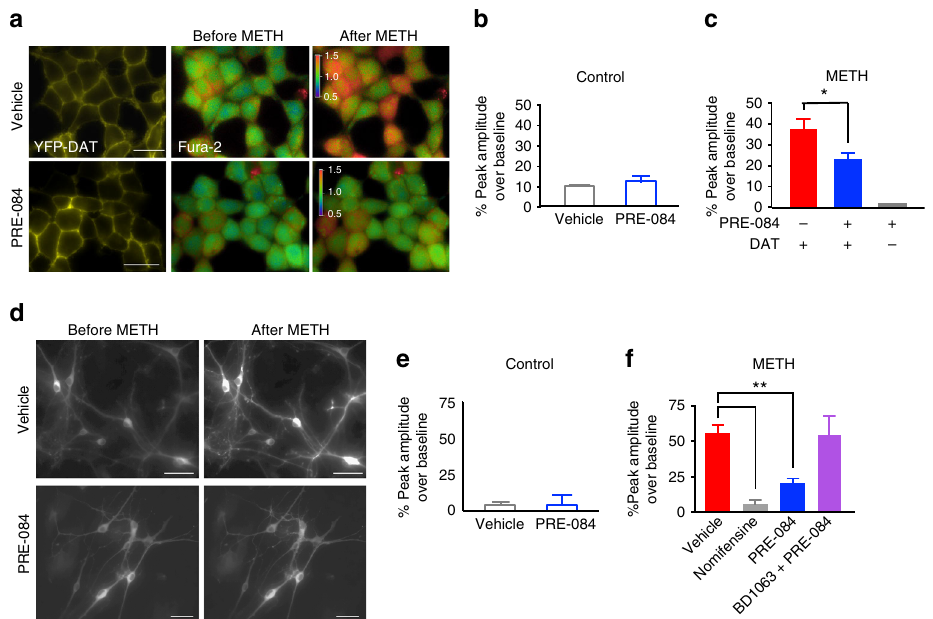
Fig. 10 σ 1 R activation signi fi cantly decreases METH-induced increases in intracellular calcium. a Representative images of YFP-DAT cells (left panel) treated with Fura-2AM before and after treatment with 10 μ M METH. Middle and right panel show the ratio 340/380 view. Scale bar is 5 μ m. The color bar in the Fura-2 images represent the color assignments for the 340/380 ratio of the cells. b PRE-084 did not change calcium levels compared to vehicle treatment. Bar graph shows the average calcium responses after acute vehicle ( n = 3) or 1 μ M PRE-084 treatment ( n = 3, n represents independent experiments including 19 – 20 cells; t = 0.699, P = 0.5159, unpaired t -test). c PRE-084 treatment signi fi cantly decreased METH-stimulated intracellular calcium increase compared to vehicle-treated cells. Bar graph shows METH-mediated calcium response over baseline in vehicle treated ( n = 8) and 1 μ M PRE-084 pretreated (30 min) cells ( n = 8). METH did not increase intracellular calcium in parental cells not expressing DAT ( n = 5) ( n represents independent experiments; F (2,18) = 3.4, P = 0.0001, one-way ANOVA, Tukey ’ s test for multiple comparisons). d Grayscale images of vehicle (top panel) or PRE-084 (bottom panel) pretreated neurons expressing the calcium indicator GCaMP6f before and after treatment with 10 μ M METH. Scale bar is 20 μ m. e PRE-084 does not change baseline calcium levels in dopamine neurons. Bar graph shows the average calcium responses after acute vehicle ( n = 19) or 1 μ M PRE-084 treatment ( n = 11) ( n represents neurons; t = 0.699, P = 0.5159, unpaired t -test). f METH increase intracellular calcium in the dopamine neurons, and this effect is blocked by pretreatment with nomifensine. PRE-084 treatment signi fi cantly decreases METH-stimulated intracellular calcium increase compared to vehicle-treated neurons. The effect of PRE-084 was blocked by pretreatment with BD-1063. Bar graph shows METH-mediated calcium response over baseline in vehicle treated ( n = 53) and 1 μ M PRE-084 pretreated (30 min) neurons ( n = 42). ( n neurons; F (3, 113) = 3.662, P = 0.0001, one-way ANOVA, Dunnett ’ s test for multiple comparisons.) Data is represented as mean ±